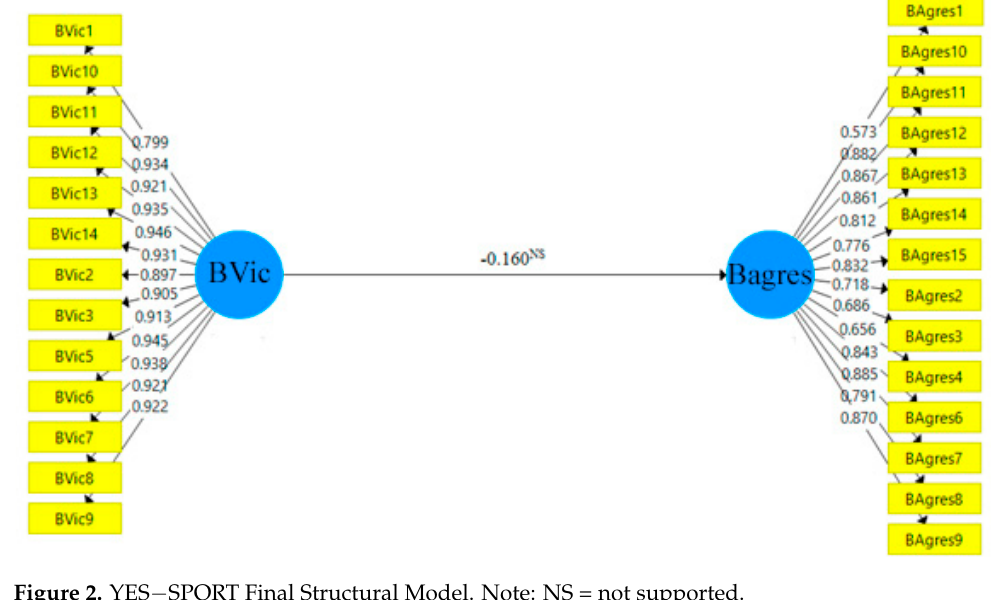
Figure 2. YES − SPORT Final Structural Model. Note: NS = not supported.